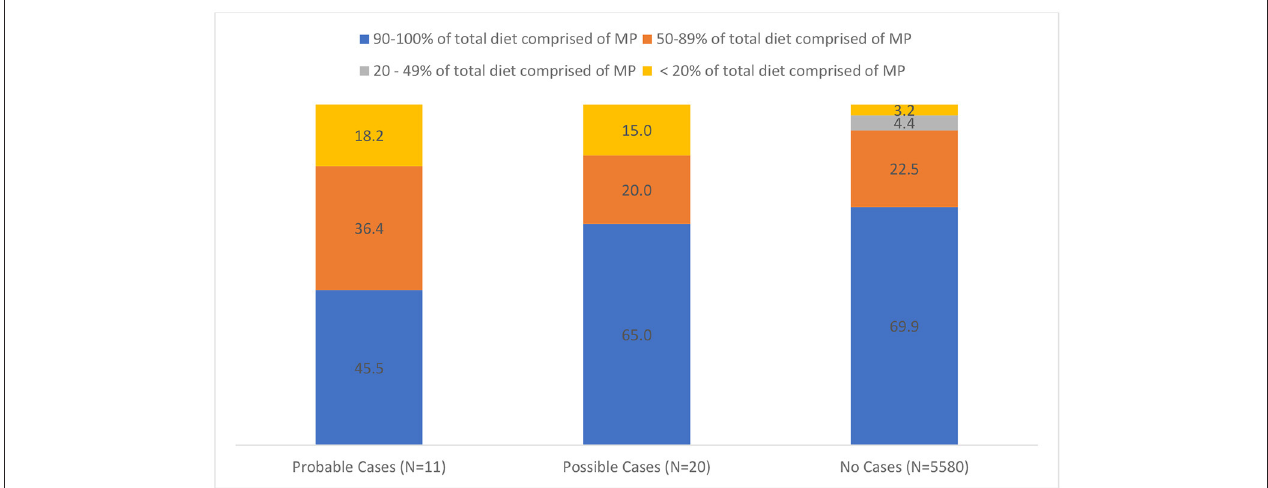
FIGURE 1 | Distribution of probable, possible, and no cases of pathogens in households feeding various percentages of minimally processed diets to cats and/or dogs.